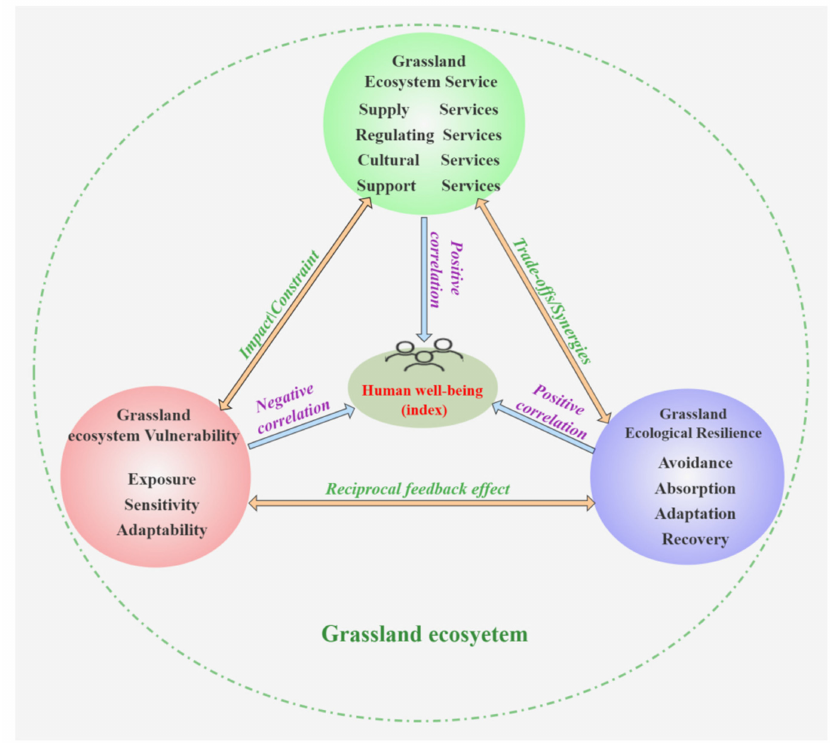
Figure 3. The relationship between grassland ecosystem vulnerability, resilience, and